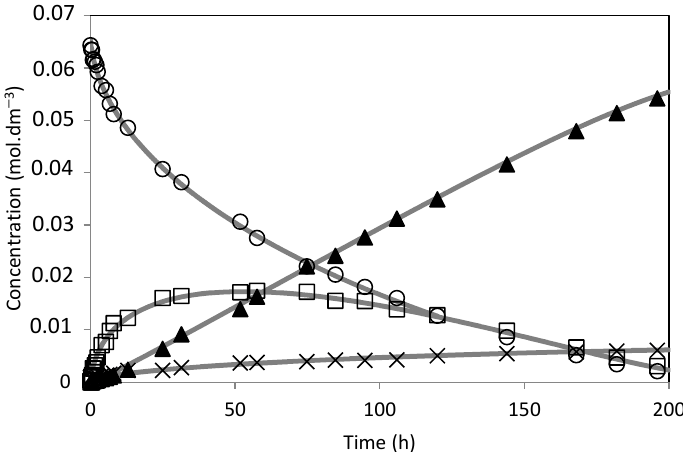
Figure 16. Camphene hydration over PW2‑SBA‑15‑SO 3 H catalyst. ( # ) Camphene; ( □ ) Camphene hydrate; ( ▲ ) Isoborneol; ( × ) Others. The lines represent the model fitted to the experimental points.